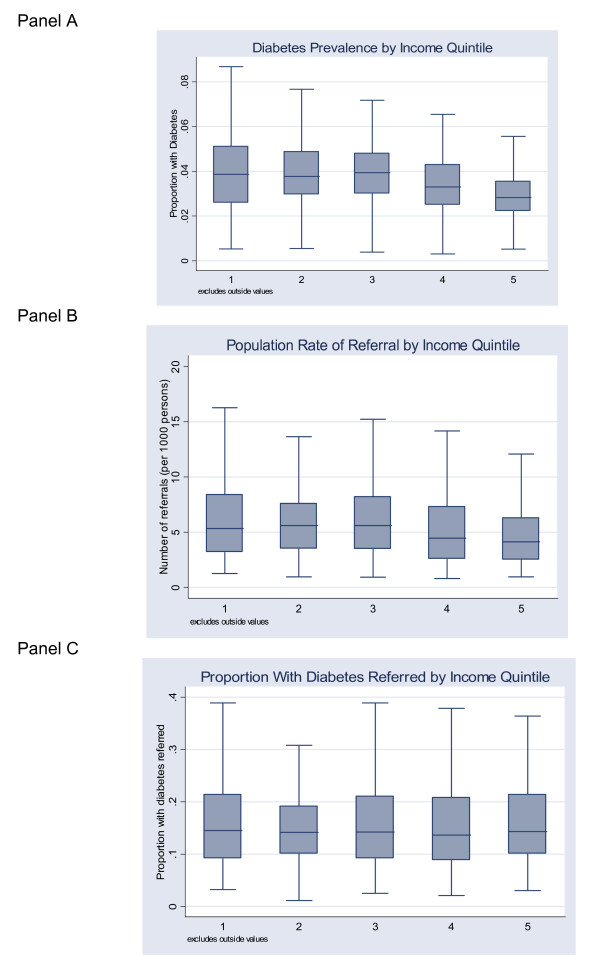
Box plots of diabetes prevalence by income quintile (panel A), population rates of DEC referral by income quintile (panel B), and proportion referred to the DEC among people with diabetes (panel C).